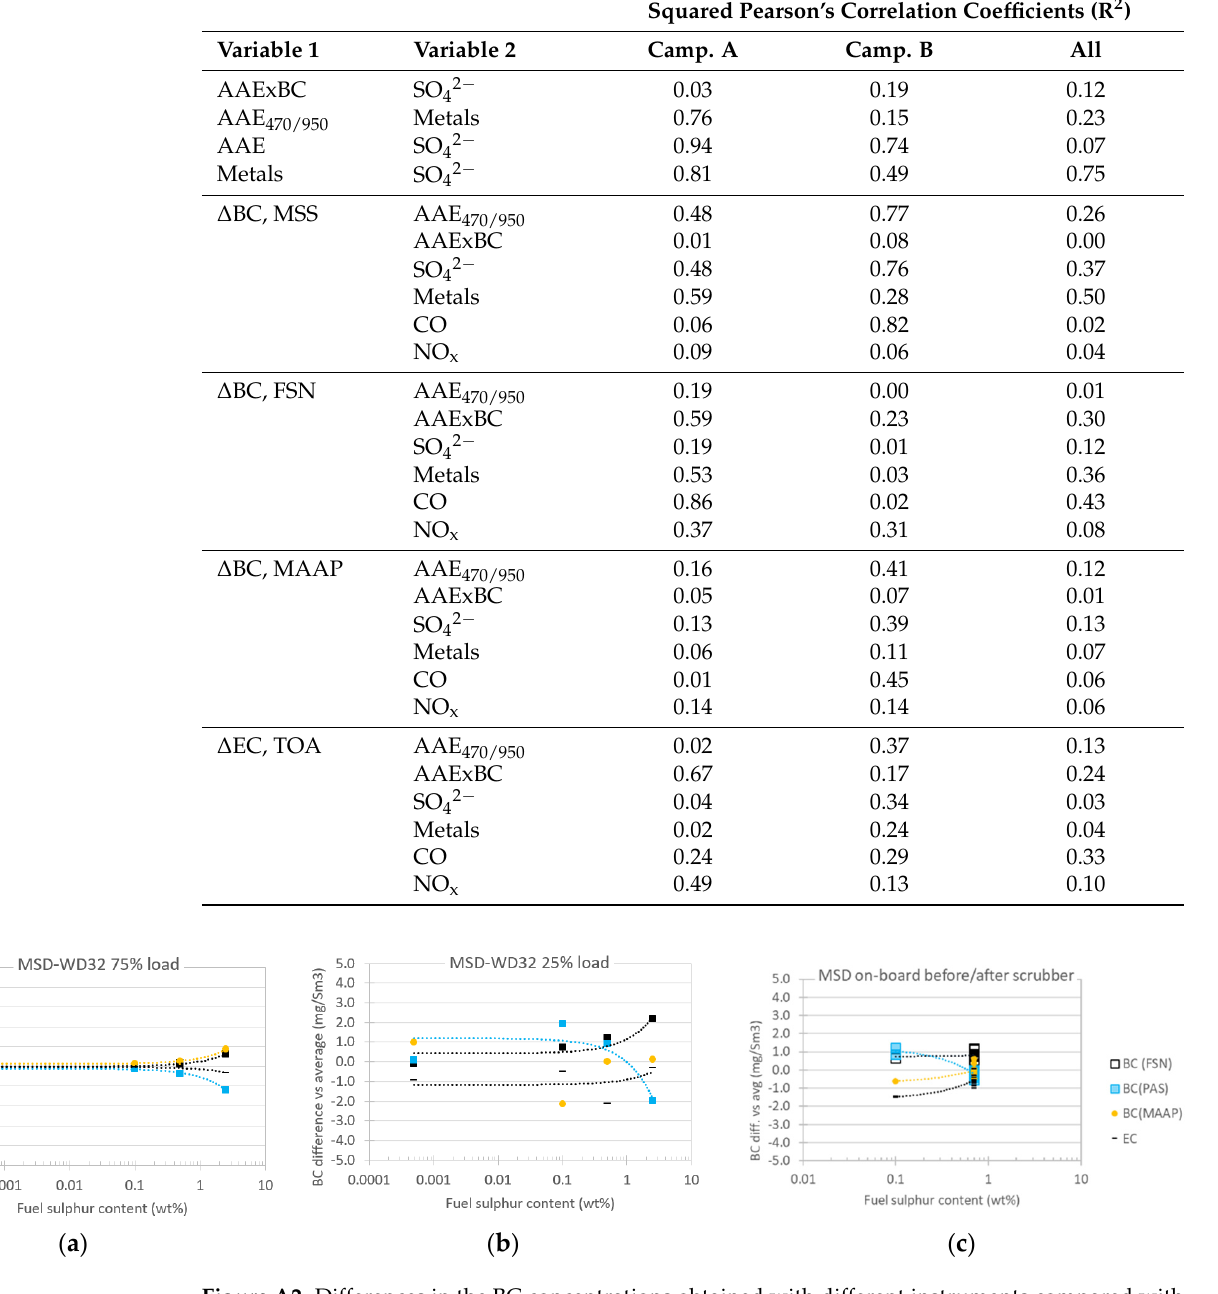
Table A2. Regression analyses between the Δ BC results and exhaust properties. Squared Pearson’s correlation coefficients in the campaigns A and B and in all campaigns. R 2 between Δ BC and OC:EC was always below 0.33.